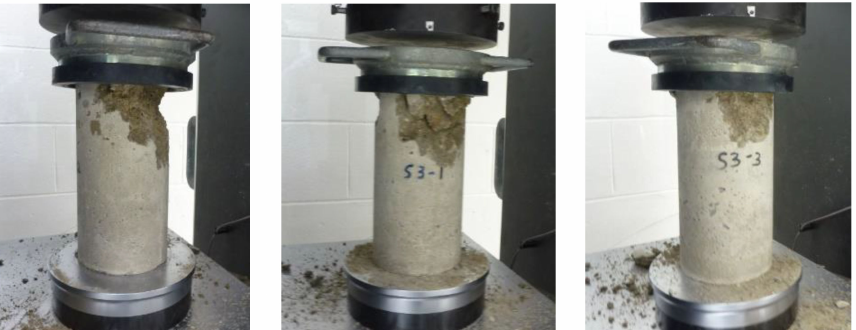
Figure 14. Compression failure patterns of C-S